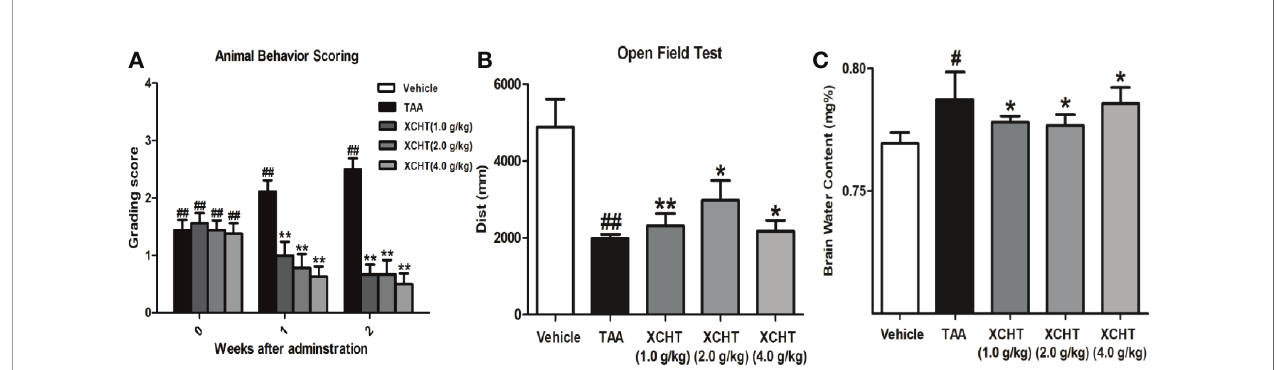
FIGURE 1 | Acute hepatic encephalopathy (AHE) was induces by repeated injection of 300 mg/kg/day thioacetamide (TAA) for 3 days (1 mL/kg in saline, i.p.). From the 4th day, the animals in treatment groups were given the XCHT granules (1.0 g/kg, 2.0 g/kg and 4.0 g/kg, 1mL/100 g/day, i.g.) for 2 weeks. (A, B) Measurement of the rat behaviors [ (A) Animal behavior scoring. (B) Open fi eld test. Rats in each group were evaluated for total distance traveled]. (C) Brain water content ([(wet weight – dry weight)/wet weight] × 100%). Data were expressed as mean ± SD (n = 5-7). # p < 0.05, ## p < 0.01 vs. the vehicle group. * p < 0.05, ** p < 0.01 vs. the TAA group.